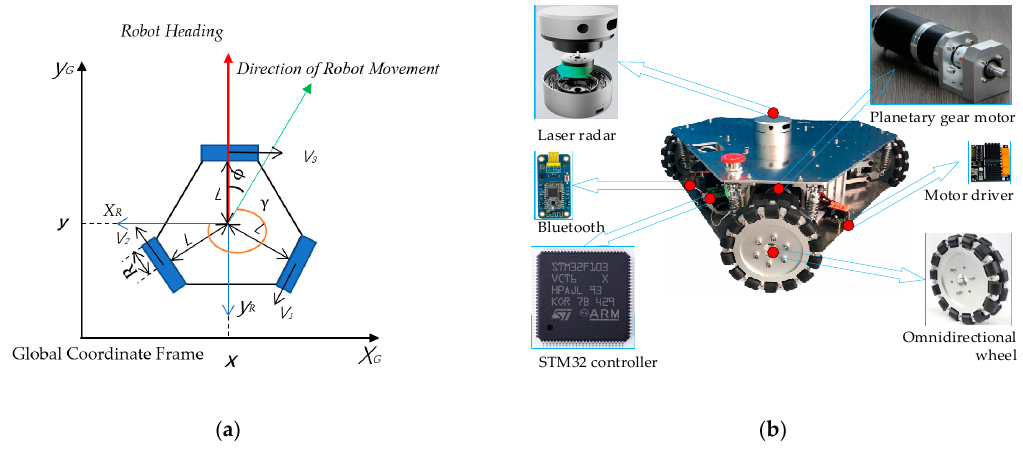
Figure 1. Three-wheeled omnidirectional mobile robot (TOMR). ( a ) Schematic of TOMR and a ( b ) schematic diagram of robot architecture.